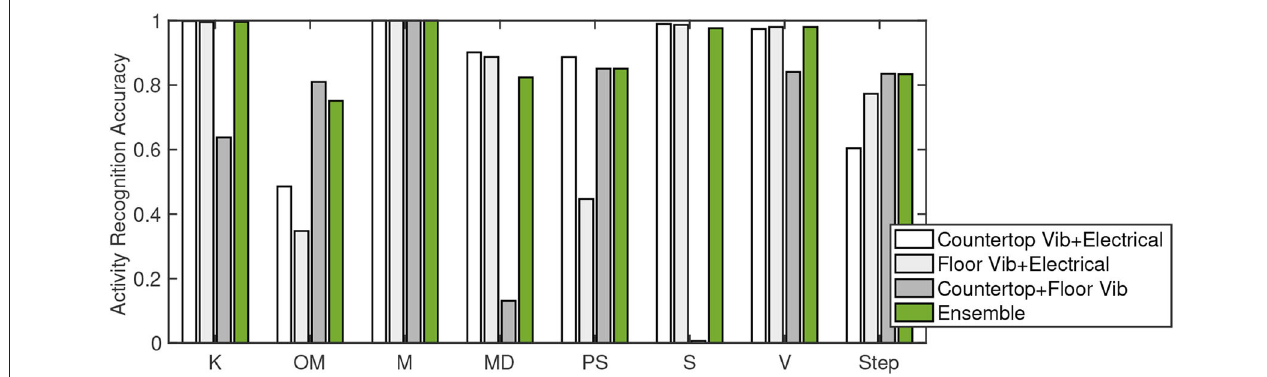
FIGURE 11 | Sliding window level ADL recognition accuracy—sensor combination analysis.